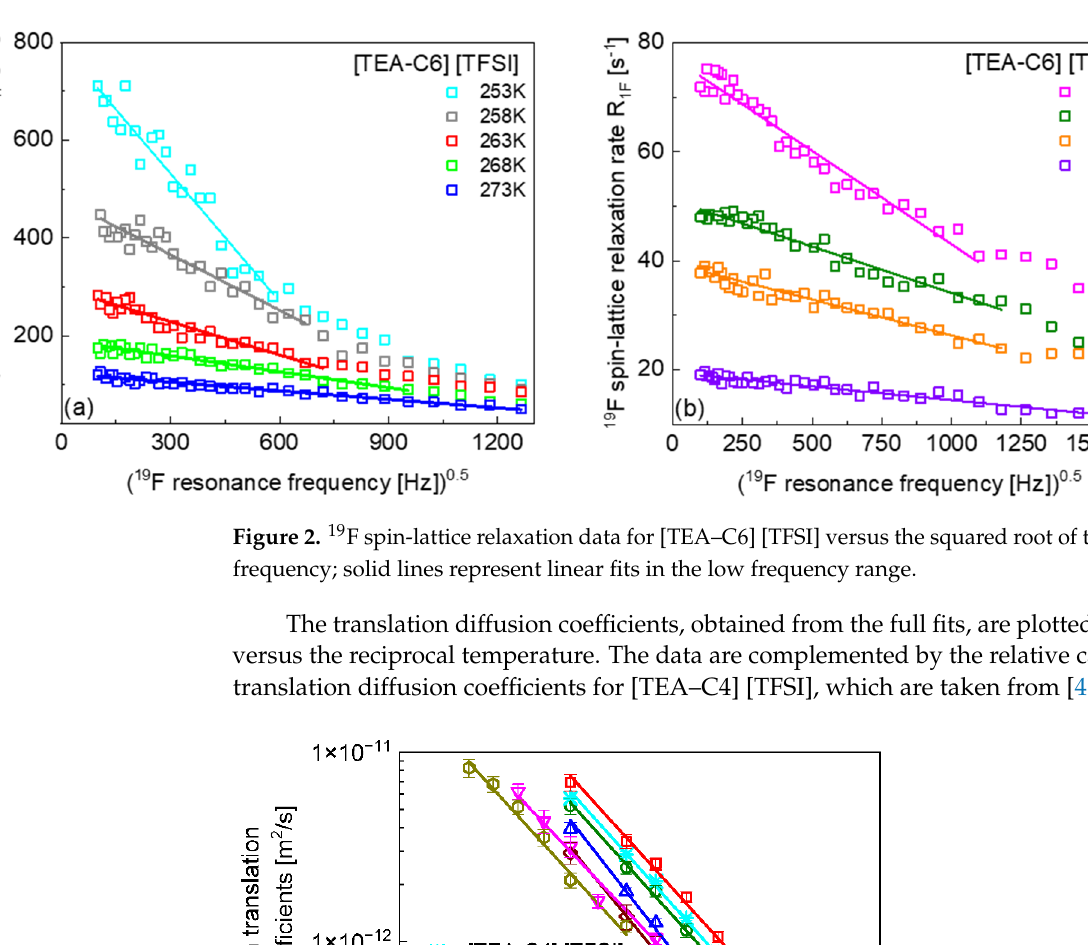
, for [TEA–C4] trans